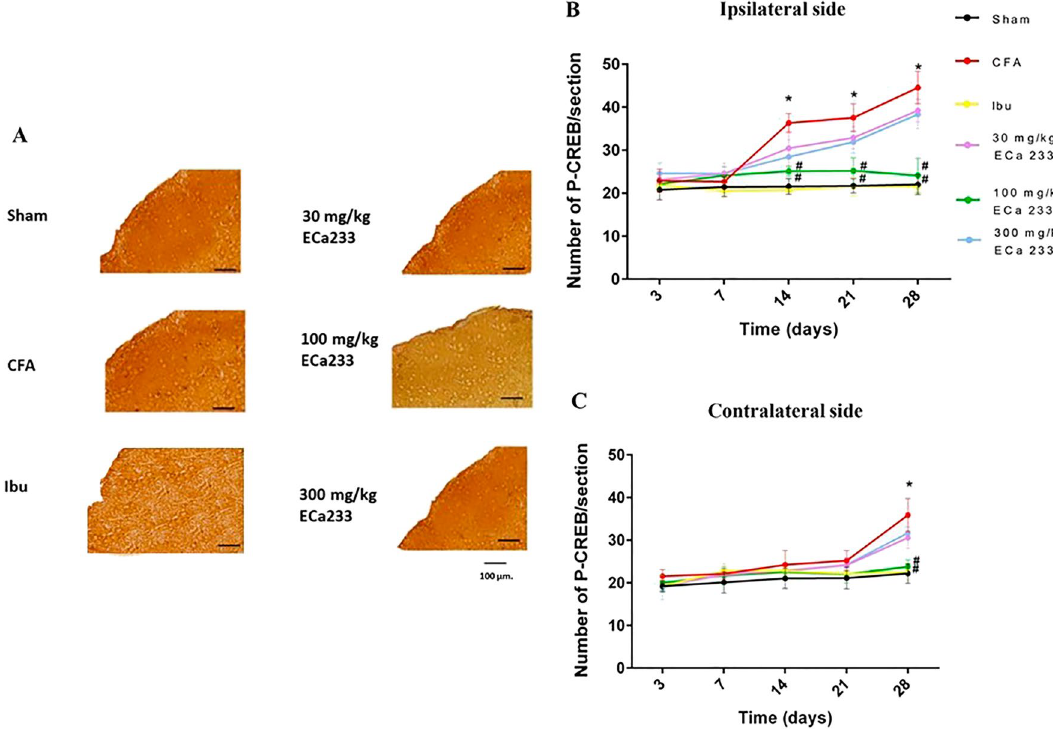
Figure 7. Phosphorylated cAMP response element-binding protein (p-CREB) expression in trigeminal subnucleus caudalis (TNC) in all groups at different time points. ( A ) An example of p-CREB staining by immunohistochemistry at the ipsilateral TNC at post–CFA-injection day 28, scale bar = 100 µm. ( B , C ) Expression of p-CREB in both sides of TNCs in different groups. In the ipsilateral TNC at post–CFA-injection days 14, 21, and 28 and in the contralateral TNC at post–CFA-injection day 28, the p-CREB expression in the complete Freund’s adjuvant–treated (CFA) group increased compared with that in the Sham group (on the ipsilateral side: day 14 [F(5,48) = 35.179, P < 0.05], day 21 [F(5,48) = 34.179, P < 0.05], day 28 [F(5,48) = 33.789, P < 0.05]; on the contralateral side: day 28 [F(5,48) = 26.885, P < 0.05]), whereas that in the groups treated with ibuprofen and 100 mg/kg ECa 233 (Ibu and 100ECa groups, respectively) significantly decreased compared with that in the CFA group (day 14 on the ipsilateral side: Ibu [F(5,48) = 21.225, P < 0.05], 100ECa [F(5,48) = 25.247, P < 0.05]; day 21 on the ipsilateral side: Ibu [F(5,48) = 22.375, P < 0.05], 100ECa [F(5,48) = 26.027, P < 0.05]; day 28 on the ipsilateral side: Ibu [F(5,48) = 24.335, P < 0.05], 100ECa [F(5,48) = 26.247, P < 0.05]; day 28 on the contralateral side: Ibu [F(5,48) = 26.245, P < 0.05], 100ECa [F(5,48) = 27.161, P < 0.05]). Both 30ECa and 300ECa showed no difference from the CFA group (day 14 on the ipsilateral side: 30ECa [F(5,48) = 40.485, P = 0.207], 300ECa [F(5,48) = 39.532, P = 0.236]; day 21 on the ipsilateral side: 30ECa [F(5,48) = 40.532, P = 0.196], 300ECa [F(5,48) = 39.532, P = 0.179]; day 28 on the ipsilateral side: 30ECa [F(5,48) = 41.485, P = 0.187], 300ECa [F(5,48) = 39.852, P = 0.196]; day 28 on the contralateral side: 30ECa [F(5,48) = 40.495, P = 0.197], 300ECa [F(5,48) = 39.972, P = 0.194]) (mean ± SEM; n = 3/group at each time; *P < 0.05 compared with the Sham group, # P < 0.05 compared with the CFA group, two-way analysis of variance followed by Fisher’s least significant difference post hoc